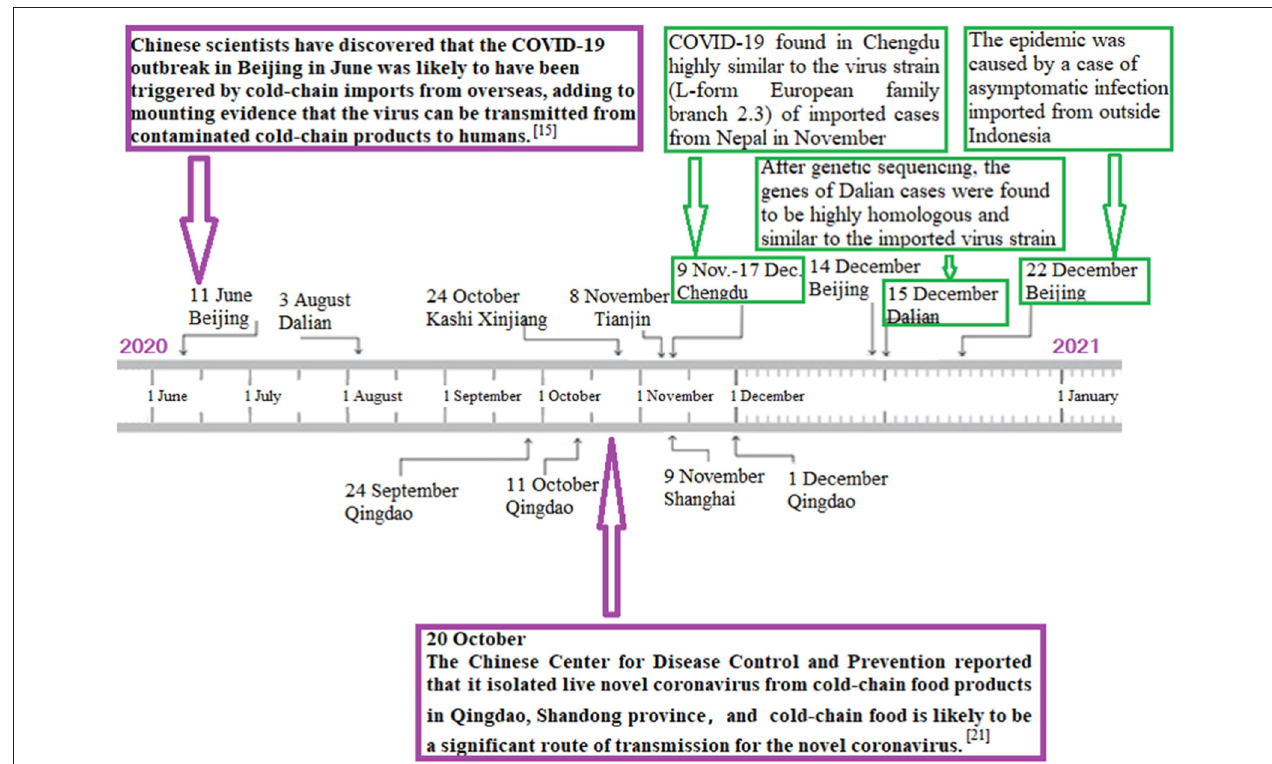
FIGURE 2 | Graph’s x-axis (dates from June 1 to December 31, 2020) is used as a timeline of key events and dynamic profile of cold-chain environment-to-human transmission during sporadic COVID-19 outbreaks in China. In Xinfadi of Beijing, Dalian, Qingdao, Kashi, Tianjin, and Shanghai, polymerase chain reaction on environmental swab samples (i.e., frozen food package) related to imported cold-chain food were positive for SARS-CoV-2. In Qingdao, live SARS-CoV-2 was isolated from imported frozen cod outer package’s surface, showing that there exists cold-chain environment-to-human transmission.